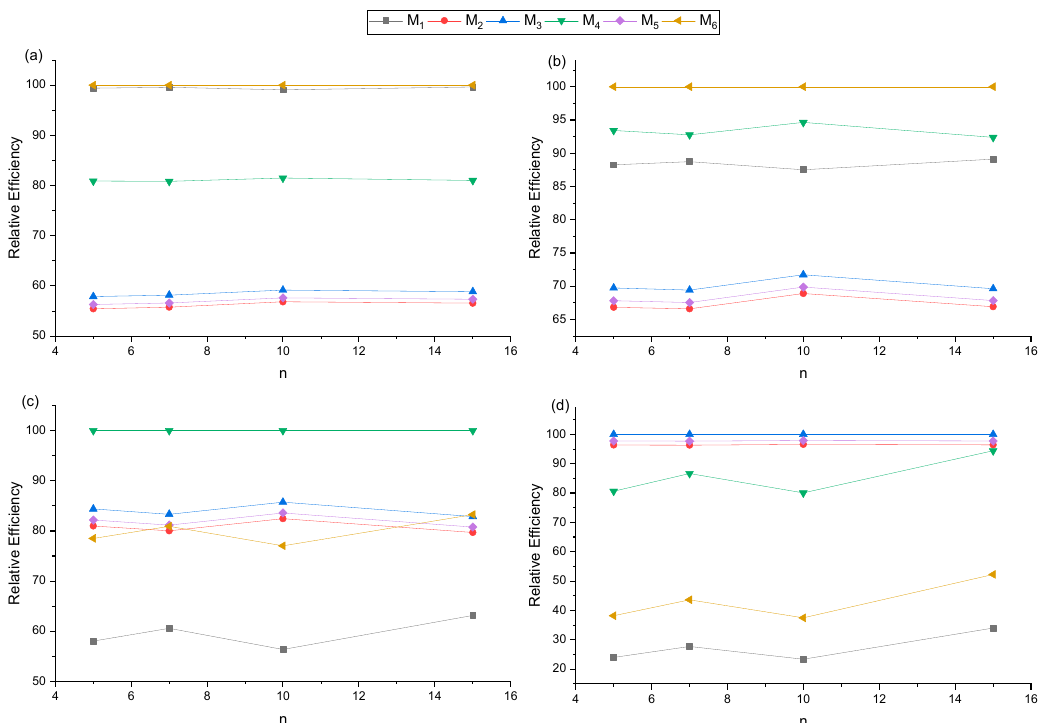
Figure 1. Comparison of relative efficiency of different median estimators at correlations: ( a ) 𝜌 = 0.30 ; ( b ) 𝜌 = 0.50 ; ( c ) 𝜌 = 0.80 ; ( d ) 𝜌 = 0.95 .